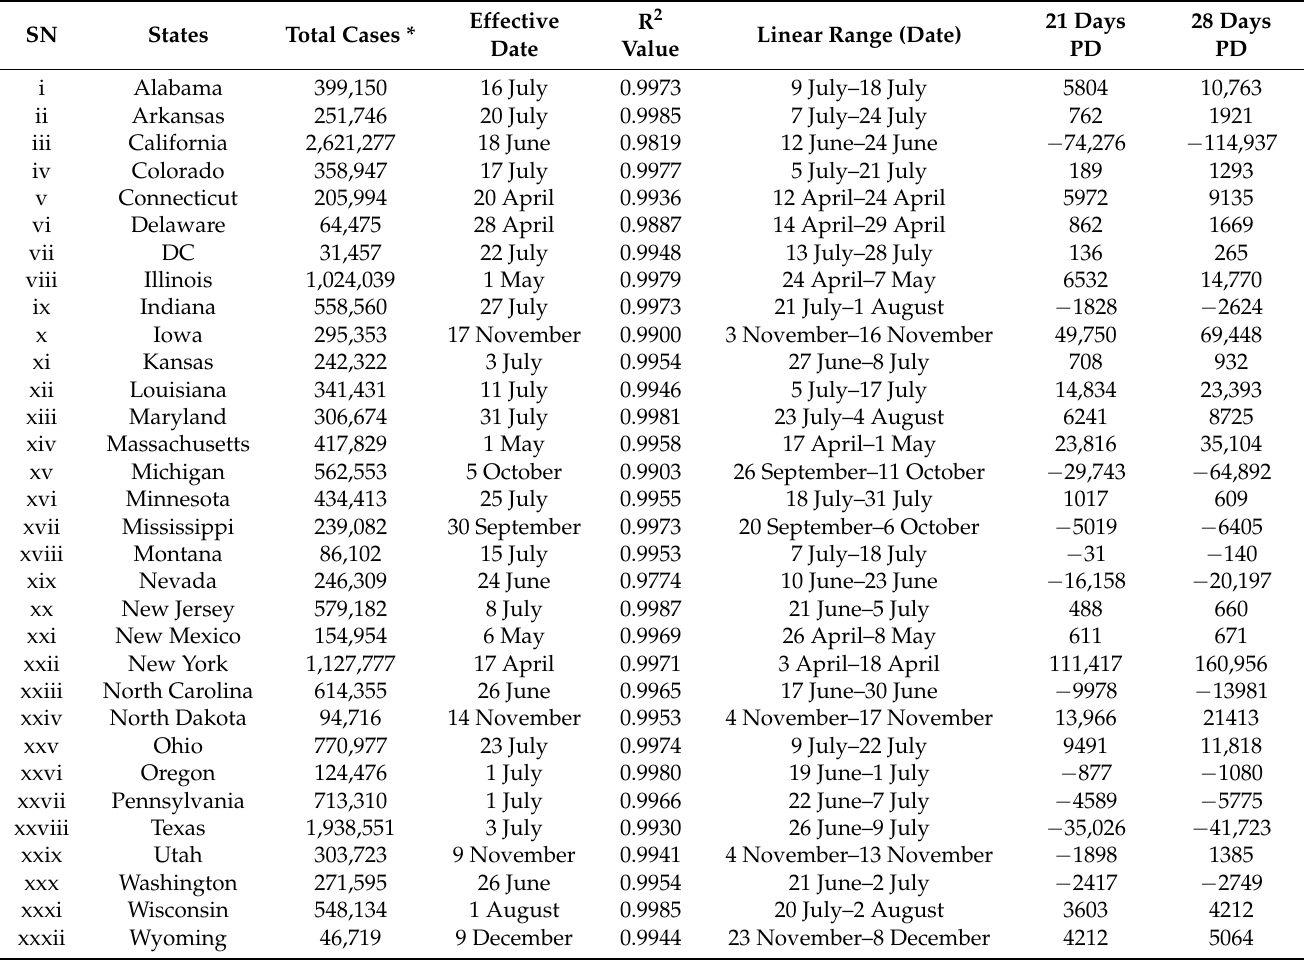
Table 1. States with face covering mandates and estimates from the projection of the number of cases prevented by 21 and 28 days after face covering mandates were